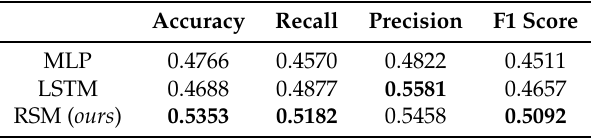
Table 1. Model evaluation scores on accuracy, recall, precision, and F1 measure. Bitcoin price in Chinese yuan (BTCCNY) from the OkCoin market is used as the dataset. We use the last 120k data points for the evaluation, which were not used in training and validation. RSM, random sampling method. The highest score among the methods is printed in bold in each